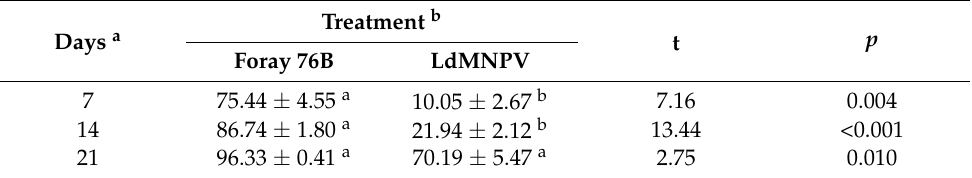
Figure 6. Survival rate of field-collected Lymantria dispar larvae from plots treated with Foray76B, LdMNPV formulation, or untreated (control). Table 4. Reduction percentage (mean ± SE) of surviving larvae in the laboratory attributable exclusively to treatments at different time intervals from bioinsecticidal application.